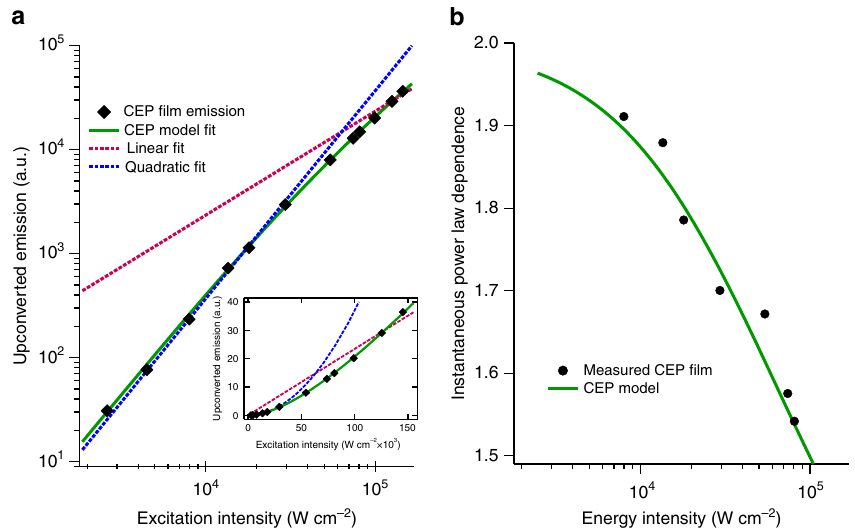
Figure 4 | Excitation intensity dependence of the CEP film. ( a ) Log-log plot of upconverted emission from the CEP film at 440 ± 20nm as a function of 540nm excitation intensity. The coloured lines are quadratic (blue) and linear (red) fits to the first and last three data points, respectively. The green line is a fit to the CEP kinetic model, discussed below. Excitation-induced film degradation precluded the collection of data at higher excitation intensities. The inset shows the same figure but scaled linearly. ( b ) Instantaneous power-law dependence of measured and modelled excitation dependence curves, showing a progression toward linear power-law dependence at higher excitation intensities. The power-law dependence was determined by the slope of a linear fit to a sliding boxcar window of six data points from the log–log plot of intensity dependence in a